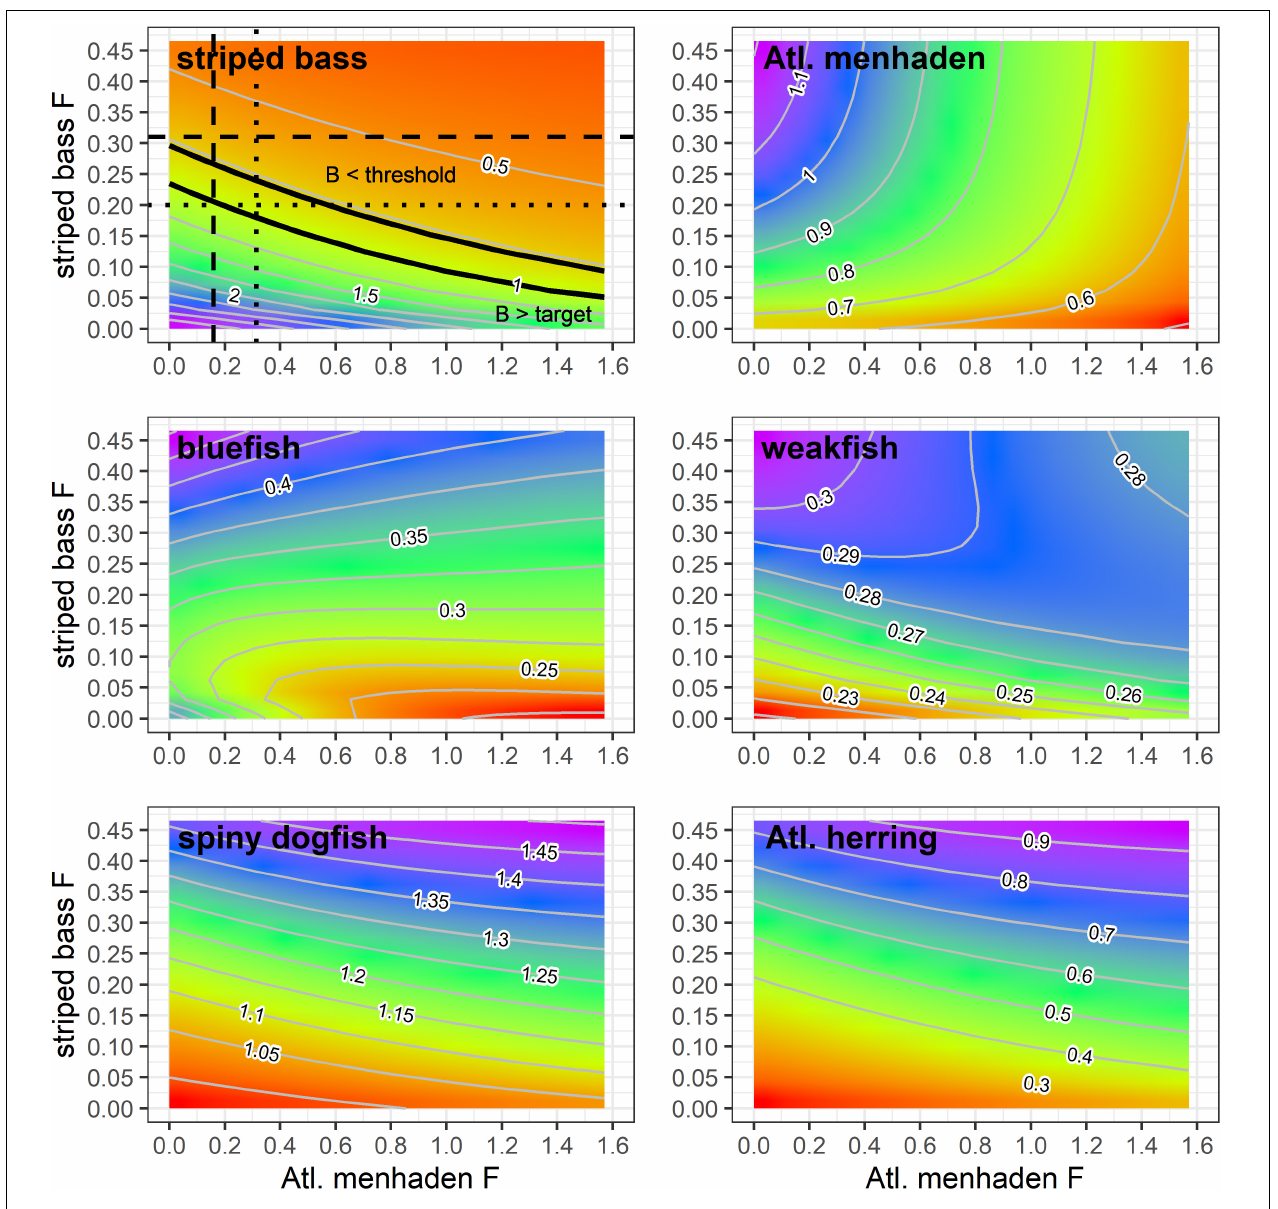
FIGURE 4 | Equilibrium biomass ratios of ERP species as a function of Atlantic menhaden and striped bass F combinations generated by the NWACS-MICE Ecosim model base run. In the striped bass panel, the dashed lines indicate the current F rates, the dotted lines are the target F rates, and the solid black lines indicate the location of the target and threshold biomass ratio contours. All ratios are expressed relative to their single species targets, except for menhaden, which is expressed relative to current (2017) biomass because biomass targets are not